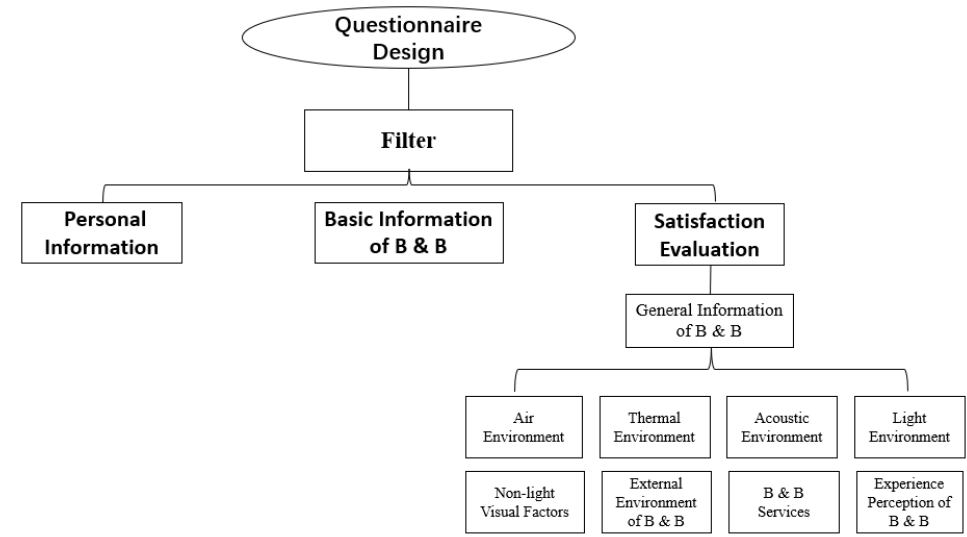
Figure 4. Questionnaire design framework.